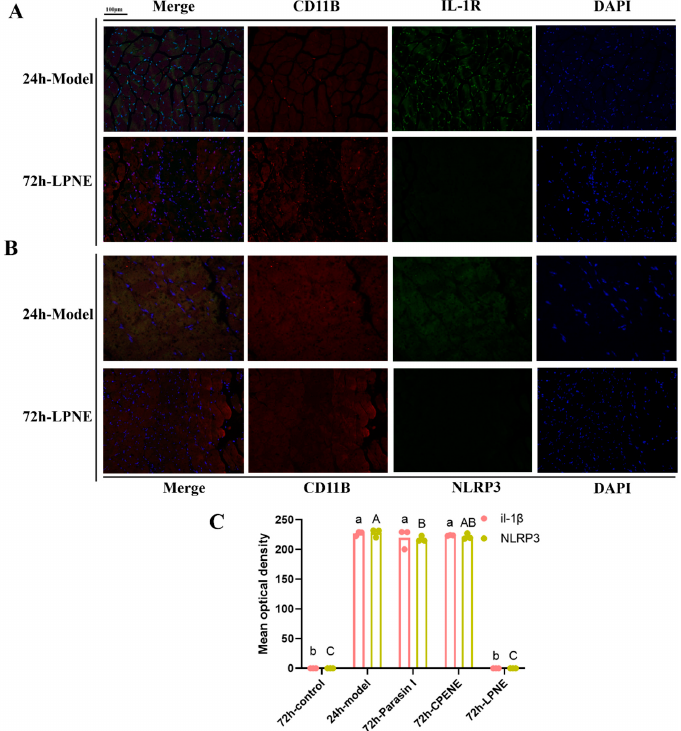
Figure 6. Il-1 β ( A ), NLRP3 ( B ) expression and their mean optical densities ( C ) in different groups. Different letters ("a", "b" or "A"–"C") indicate significant differences ( p < 0.05).